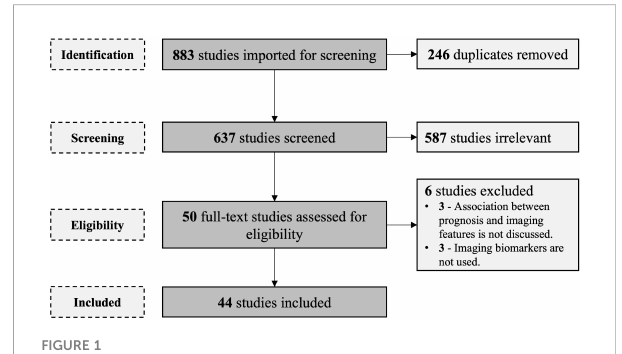
FIGURE 1 PRISMA fl ow diagram for the article